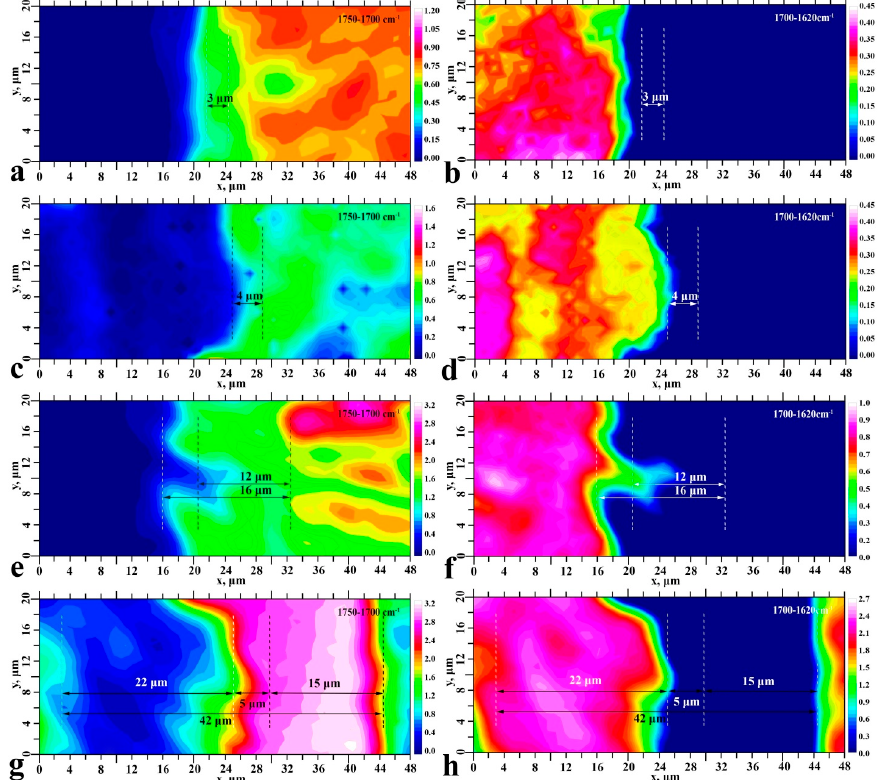
Figure 4. Chemical images of typical surface areas and reflecting the spatial distribution in the interface region (see Figure 1) of -COOCH 3 ( a , c , e , g ) ester group vibrations and Amid I vibrations ( b , d , f , h ). Sample S I —( a , b ); sample S II —( c , d ); sample S III —( e , f ); sample S IV —( g , h